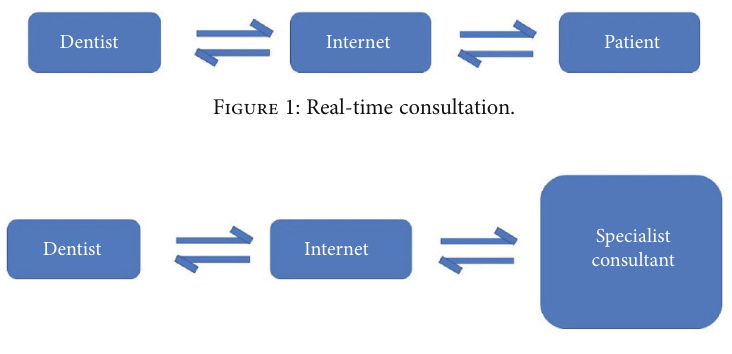
Figure 2: Store-and-forward method of